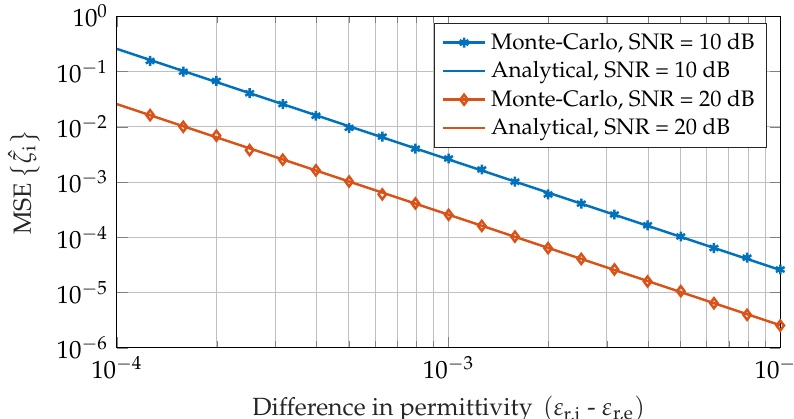
Figure 3. Monte-Carlo simulation of the mean square error MSE { ζ i } for N = 4096, f 0 = 77GHz, d m = 0.5 and air as reference and environmental gas with ε r,ref = ε r,e = 1.000536. The inclusion gas permittivity is sweeped to vary the permittivity difference ε r,i − ε r,e in the range 10 − 4 to 10 − 2 .